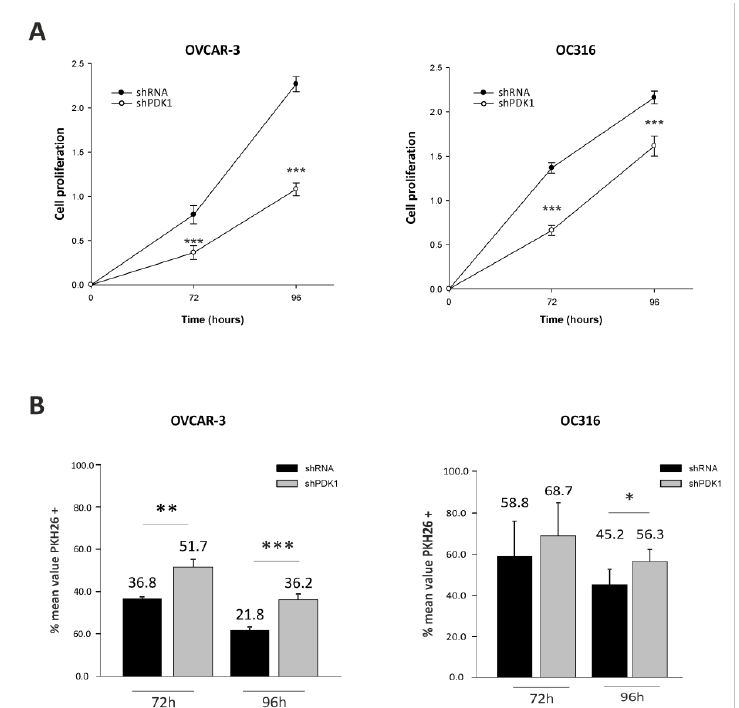
Figure 3. Effects of PDK1 silencing on cell proliferation. ( A , B ) Cell proliferation was reduced in PDK-silenced cells compared to control cells by sulforhodamine (SRB) assay and was confirmed by PKH26 staining. * p < 0.05, ** p < 0.01, *** p < 0.001, t test. Data are mean ± SD values of two